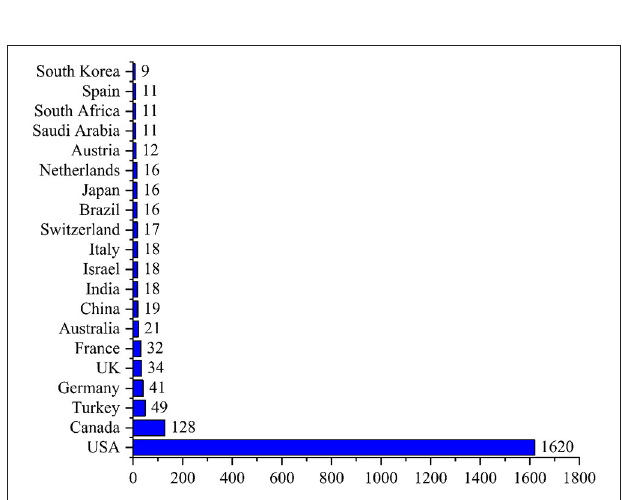
FIGURE 7 | Top 20 most active countries in pediatric trauma research.